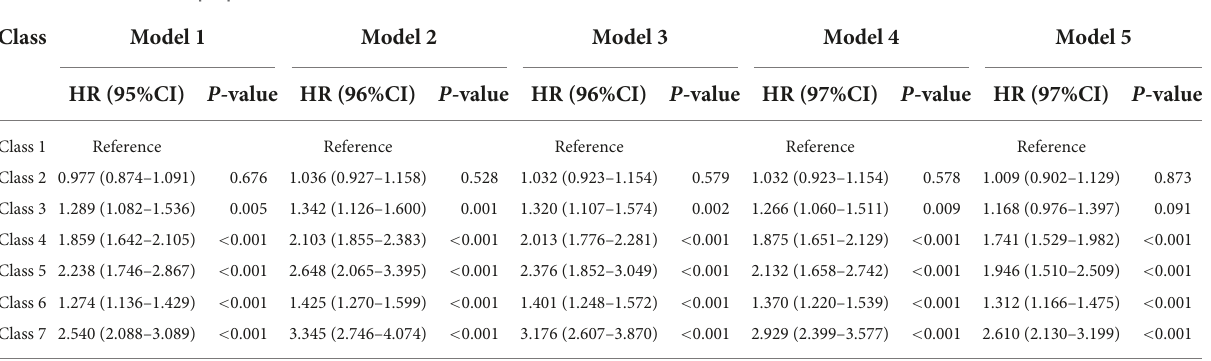
TABLE 3 Results of Cox proportional hazard